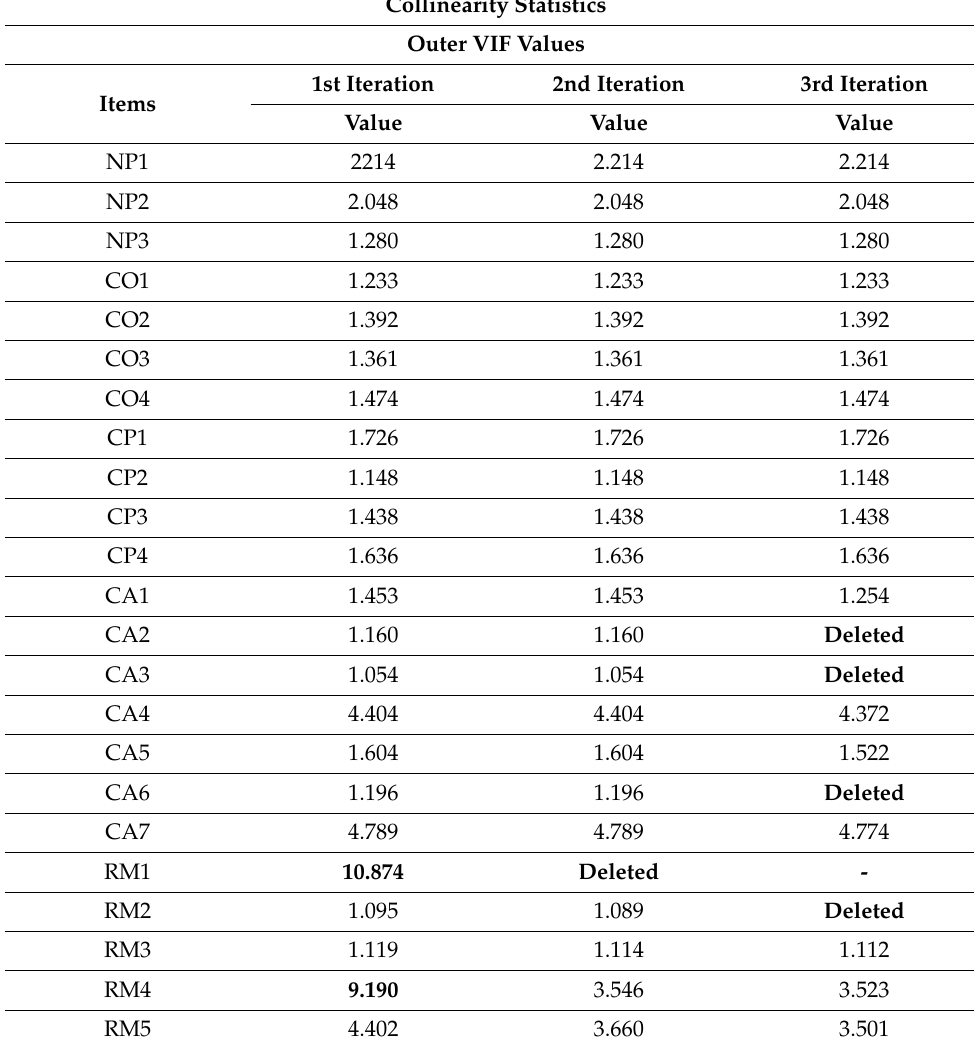
Table A7. Collinearity Statistics.